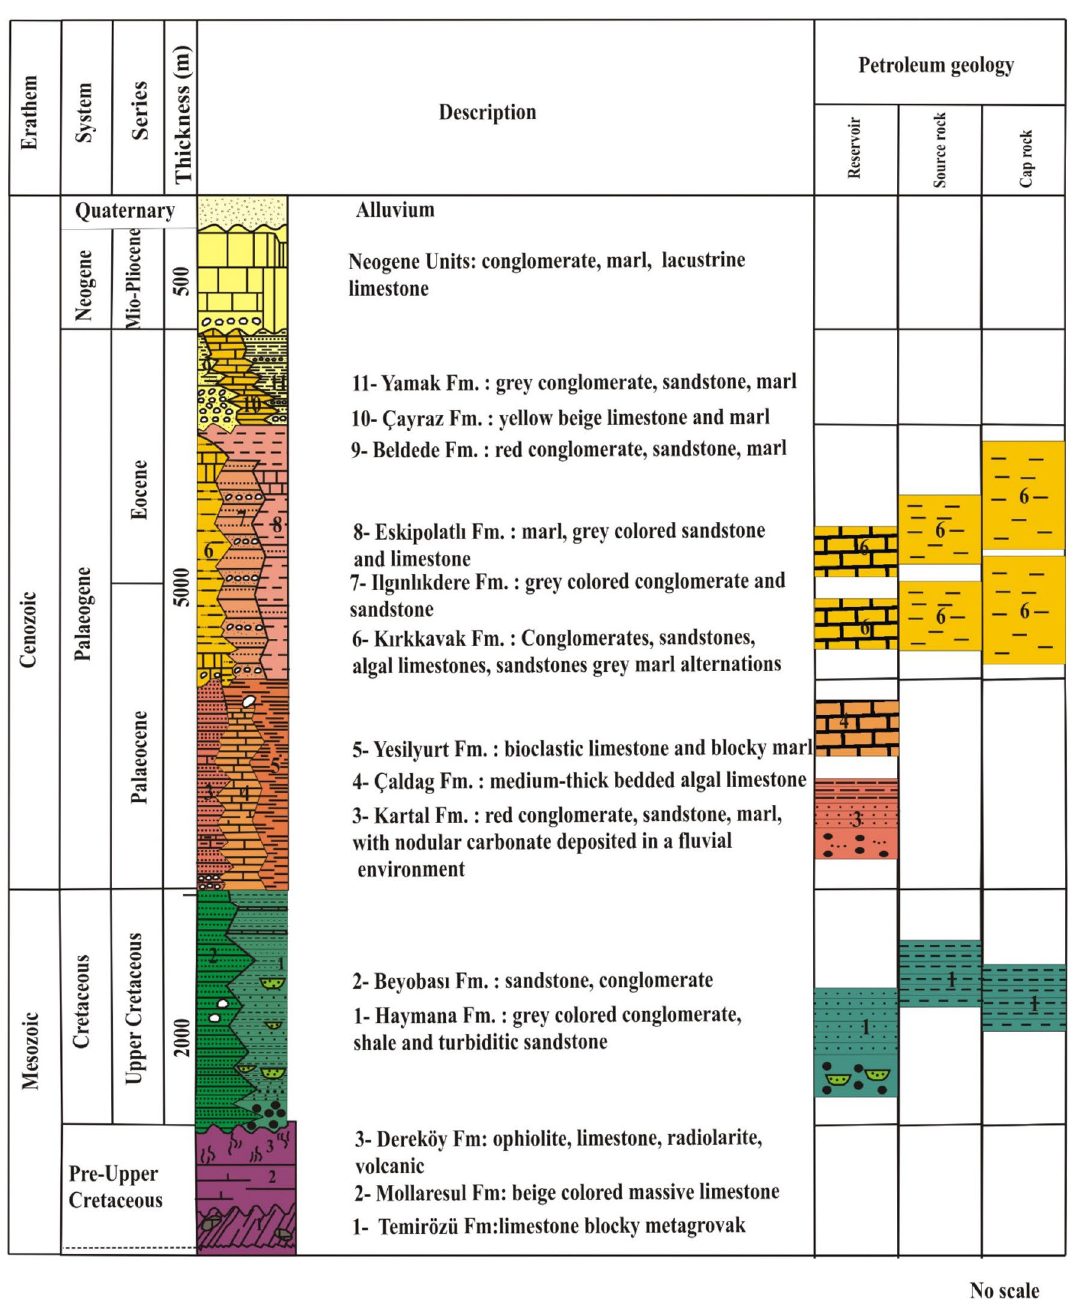
Fig. 3 General stratigraphic column section of the Haymana Basin. Modified after Ünalan et al. (1976 and Sirel et al. (1986).